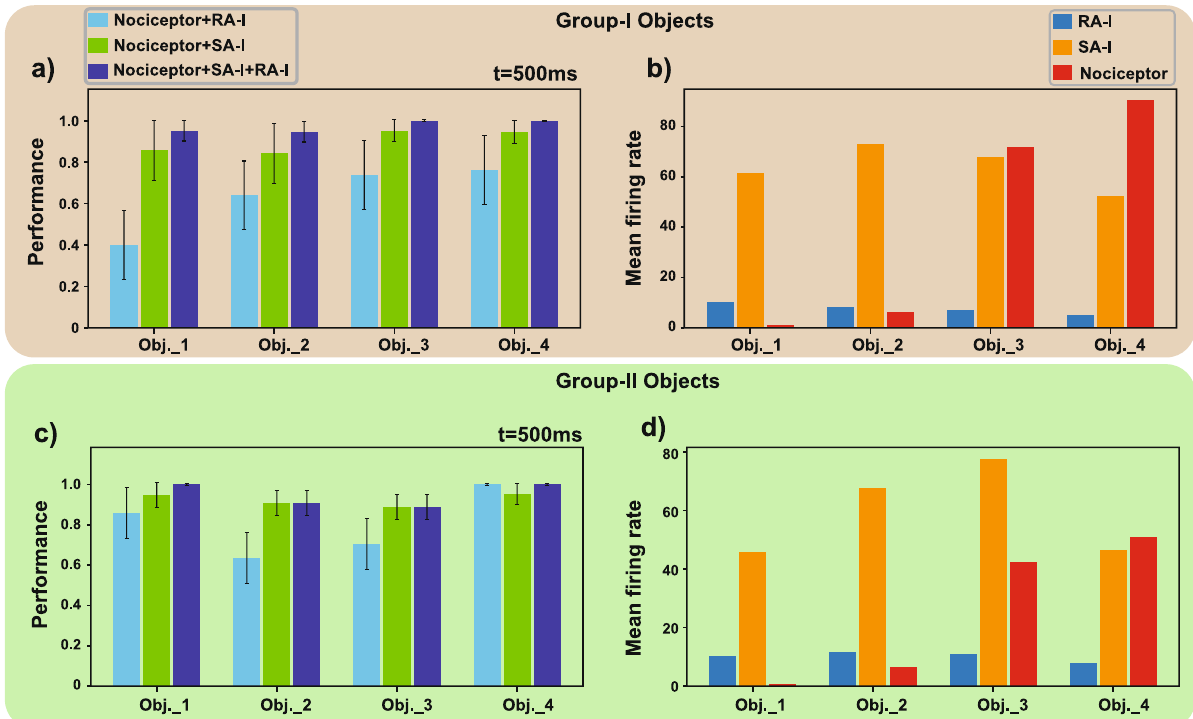
Figure 5. Contribution of the individual bio-inspired afferents and nociceptors in sharpness detection. Classification accuracy for each population of SA-I/RA-I/nociceptor and their combination for ( a ) Group-I objects and ( c ) Group-II objects. The mean firing rate of digital afferents and digital nociceptors during the response to ( b ) Group-I and ( d ) Group-II objects. For the sharpness classification, the spike count algorithm for 500 ms has been